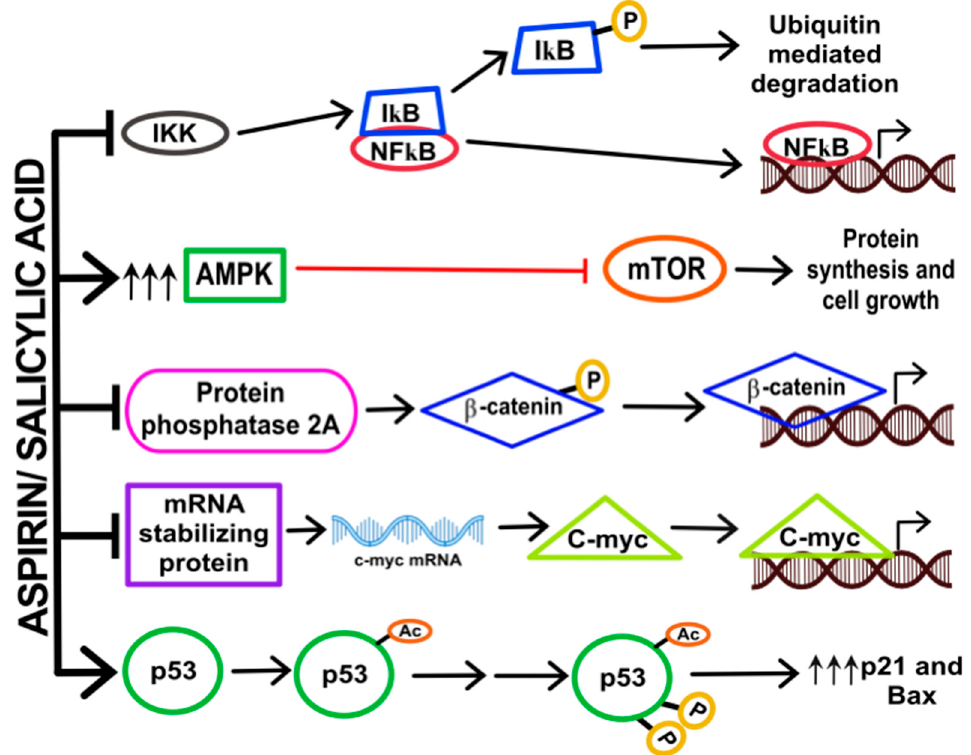
Figure 3. Other pathways. Aspirin / Salicylic has been shown to modulate a variety of signaling pathways which may also contribute to its anti-cancer e ff ects. It is known to inhibit nuclear factor (NF)- κ B pathway, activate the adenosine monophosphate activated protein kinase (AMPK) pathway, inhibit the Wnt / β -catenin signaling pathway, cause degradation of c-myc mRNA and proteins, and acetylate p53 leading to induction of p21 and Bax protein expression, to name a few. See text for details; additional pathways described in the text are not depicted in this figure. -P, phosphorylated protein; -Ac, acetylated protein.